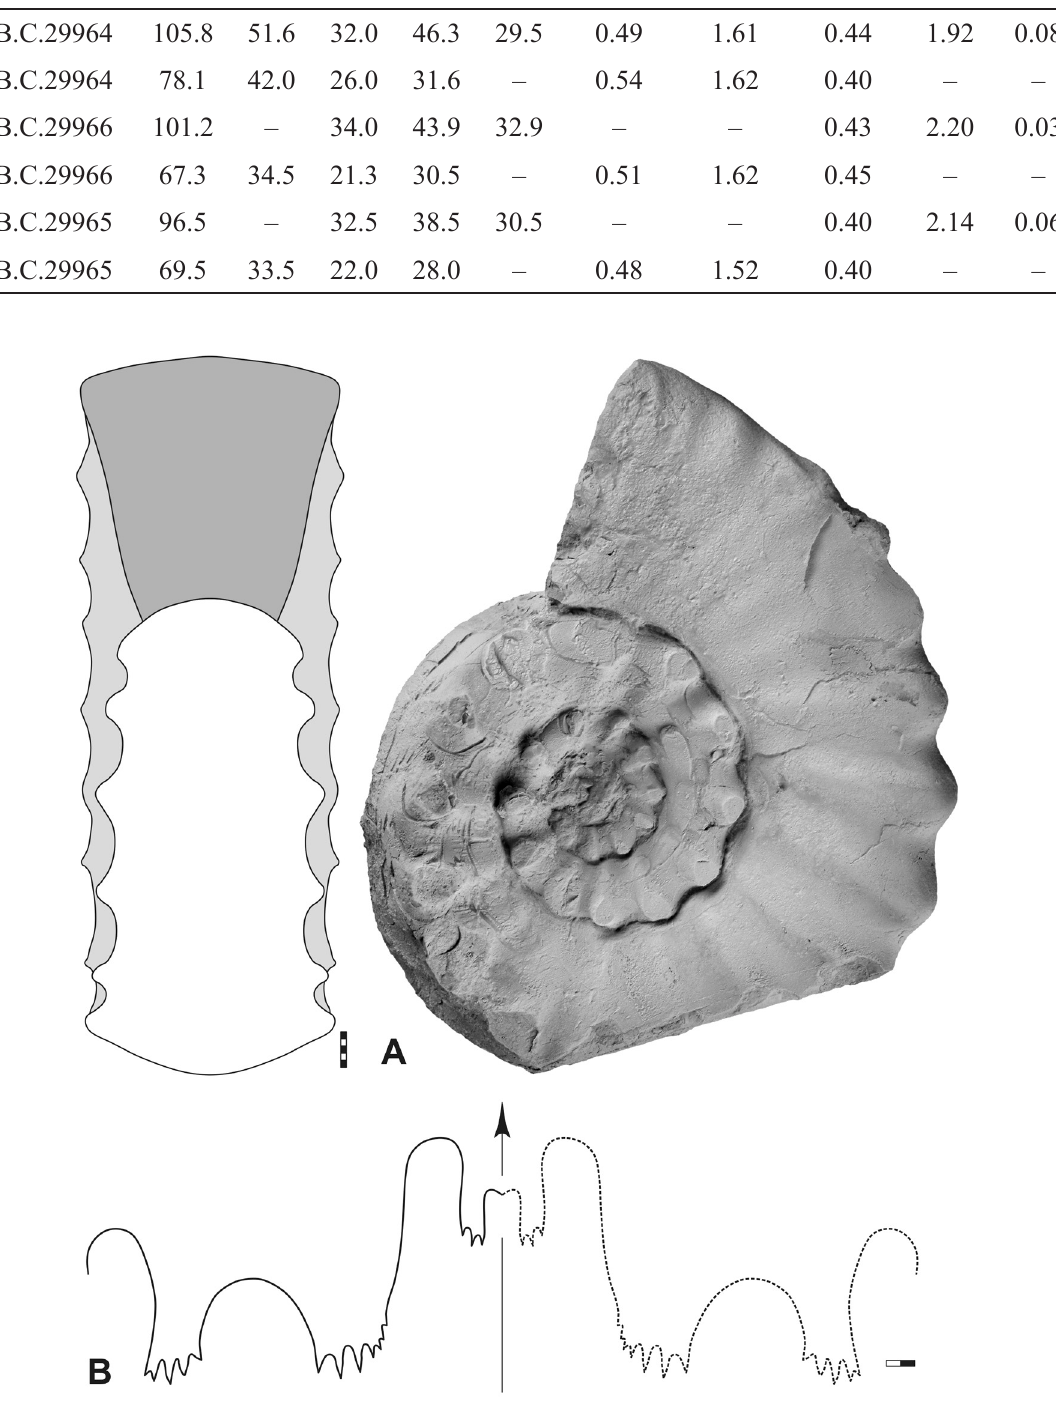
Fig. 46. Esfahanites armatus Korn & Hairapetian gen. et sp. nov., paratype MB.C.29966, section G, float. A . Lateral and dorsal view. B . Suture line, at 56.0 mm dm, 36.0 mm ww, 19.0 mm wh. Abbreviations: see Material and methods. Scale bar units = 1 mm.